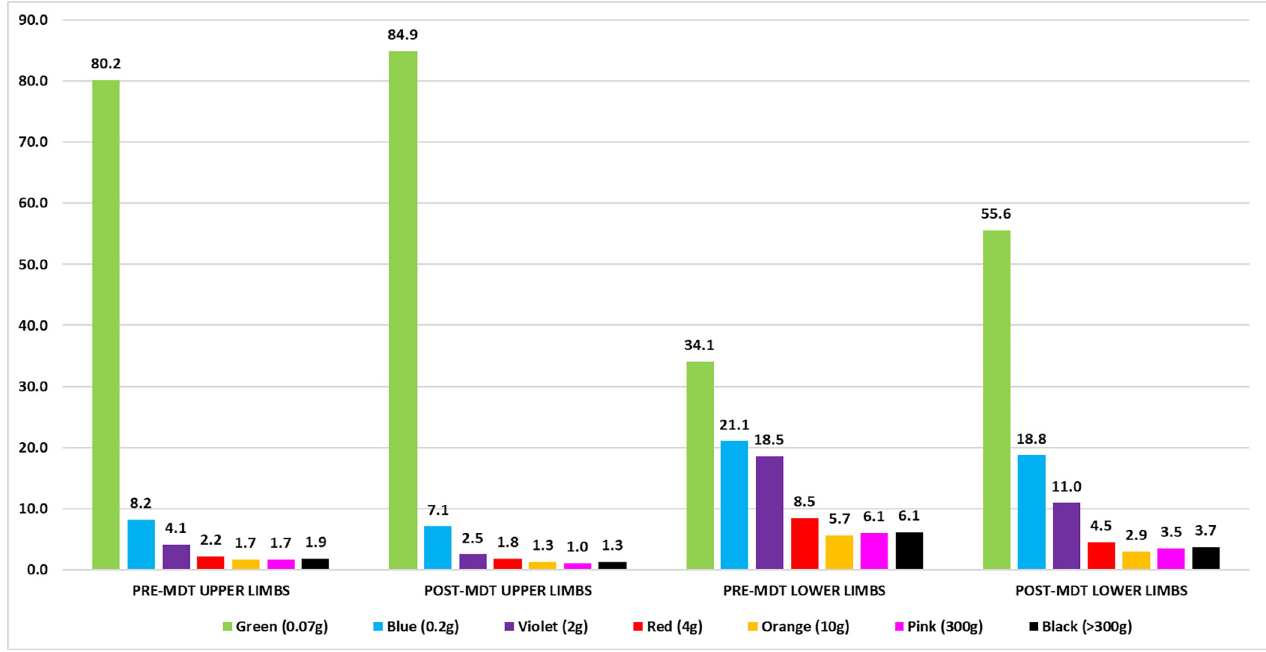
Fig 4. Percentage distribution of the number of SWM-test points of the upper and lower limbs at diagnosis and after the end of treatment of patients diagnosed with leprosy in Jardino´polis from 2016 to 2019.